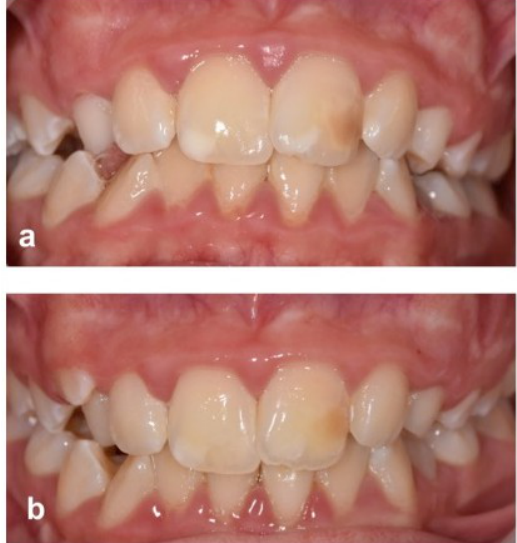
Figure 2. Clinical images to demonstrate both a successful clinical outcome and unacceptable aesthetic result. ( a ) Maxillary central incisors showing cream/white opacity (right) and white and brown opacities (left) pre-treatment. ( b ) Microabrasion followed by resin infiltration achieved good aesthetic results on the right central incisor, but brown opacity was still visible on the left central incisor, necessitating further resin composite